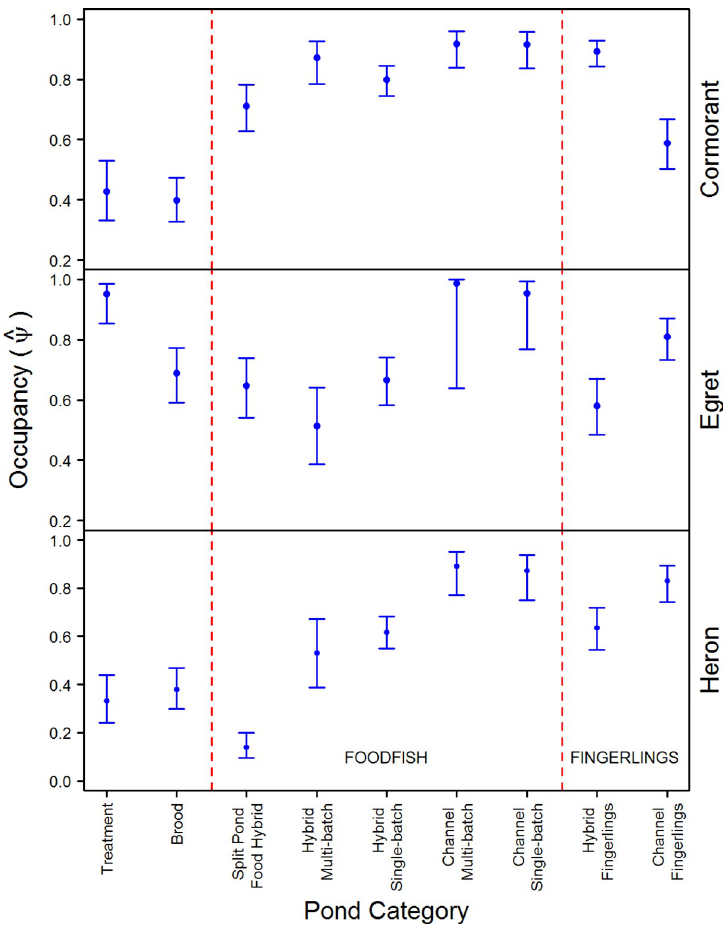
Fig 4. Occupancy probability (+ 95% CI) of catfish ponds in the Mississippi Delta by pond category for cormorants, egrets, and herons. Estimates were made using the top ranked model for each species, while holding all other variables at their mean value based on pond